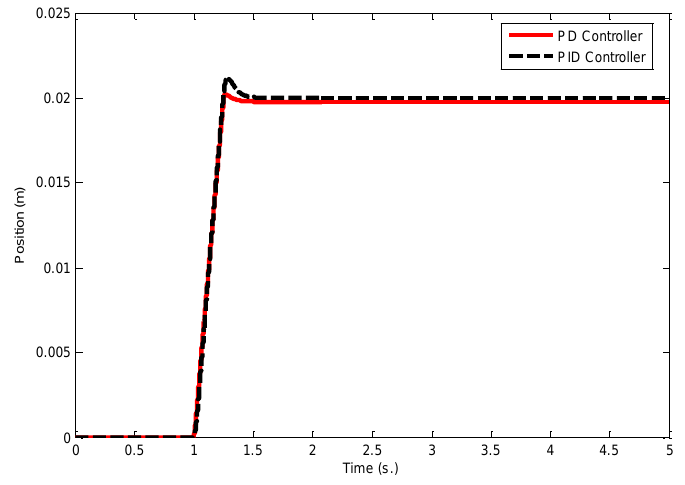
Figure 7. Position control responses when PD and the proposed PID controllers are used, and there is no external